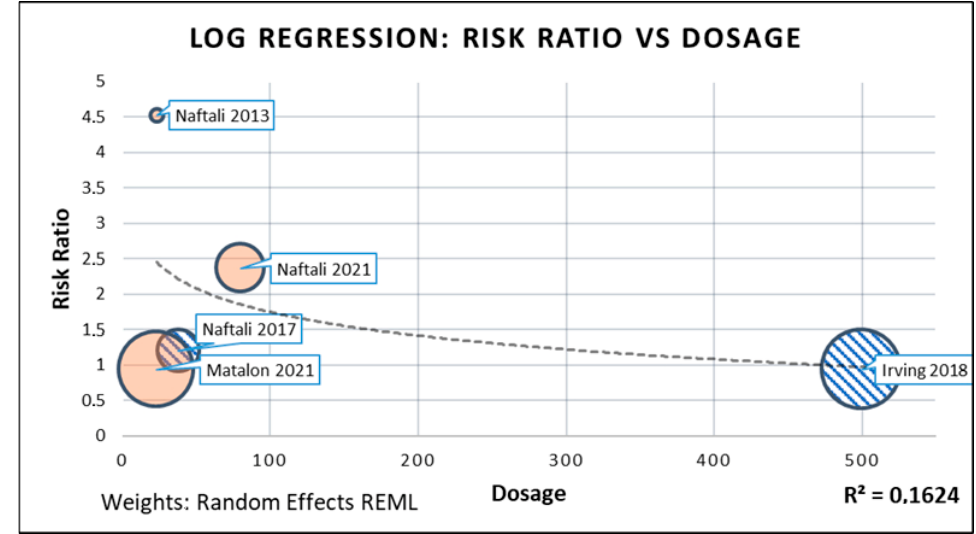
Figure 8. Log meta-regression. Red bubbles represent smoked administration of cannabinoids; blue-barred bubbles represent oral administration of cannabinoids.